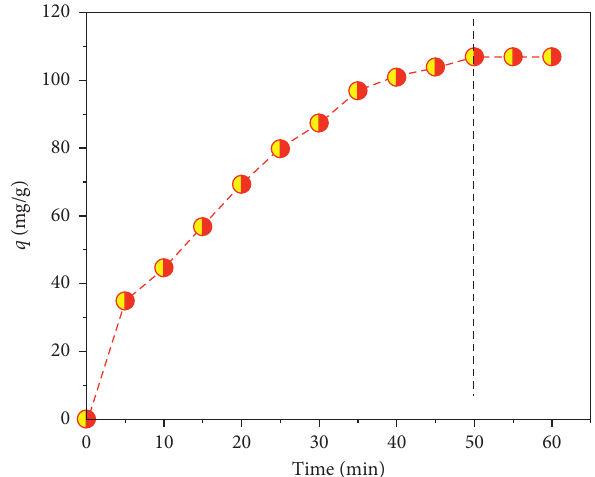
Figure 10: Variation in adsorption capacity of RBB at optimum conditions.